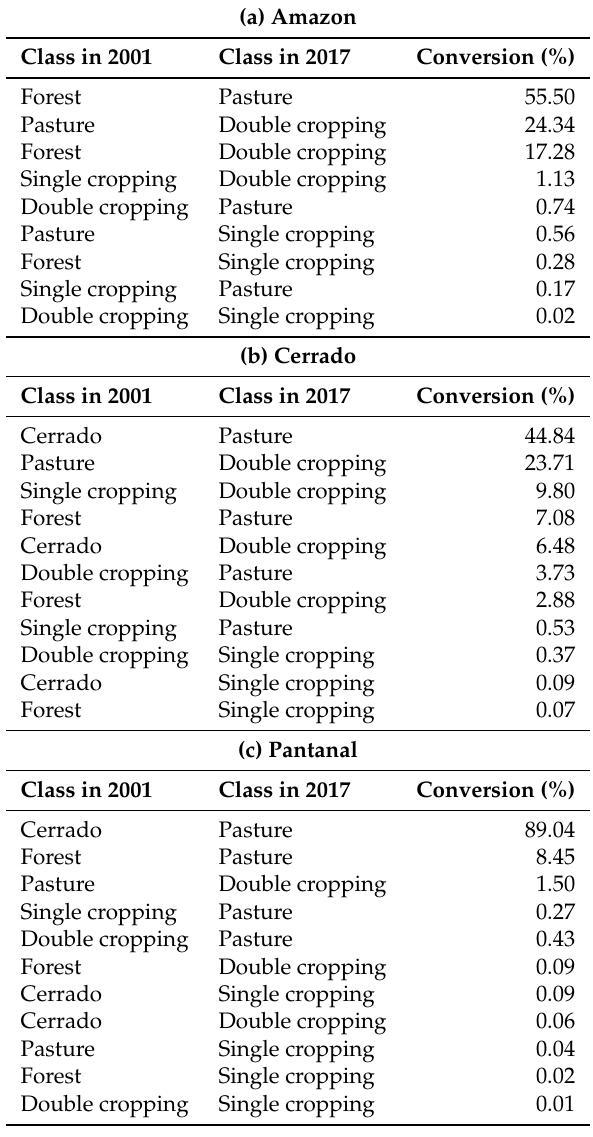
Table 3. Percentage of land use and land cover conversions in the portions of the Mato Grosso